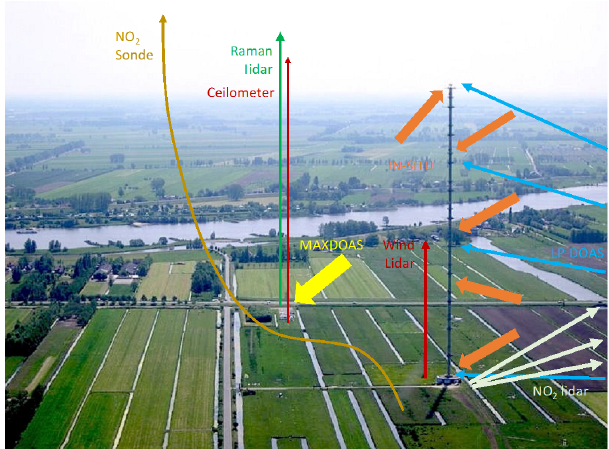
Figure 18. Schematic layout of the CINDI-2 campaign superim- posed on an aerial picture of the CESAR site. Main instrument classes are indicated. The NO 2 -sondes were launched from close to the tower. A long-path DOAS was placed at a distance of about 4km from the tower that was able to scan several retroreflectors at different altitude